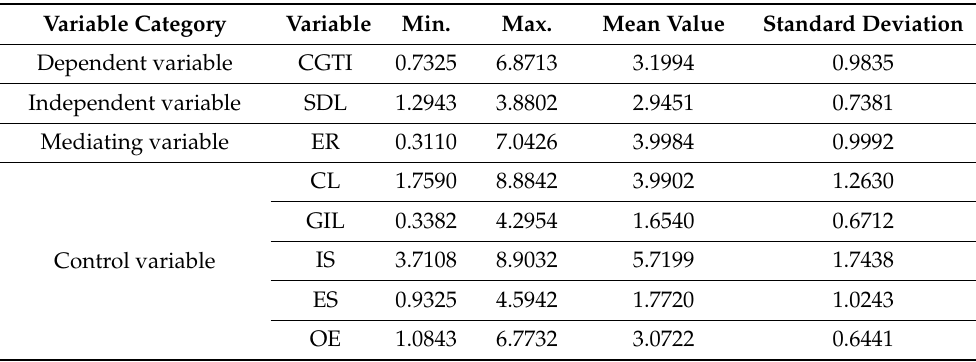
Table 2. Descriptive statistical results of